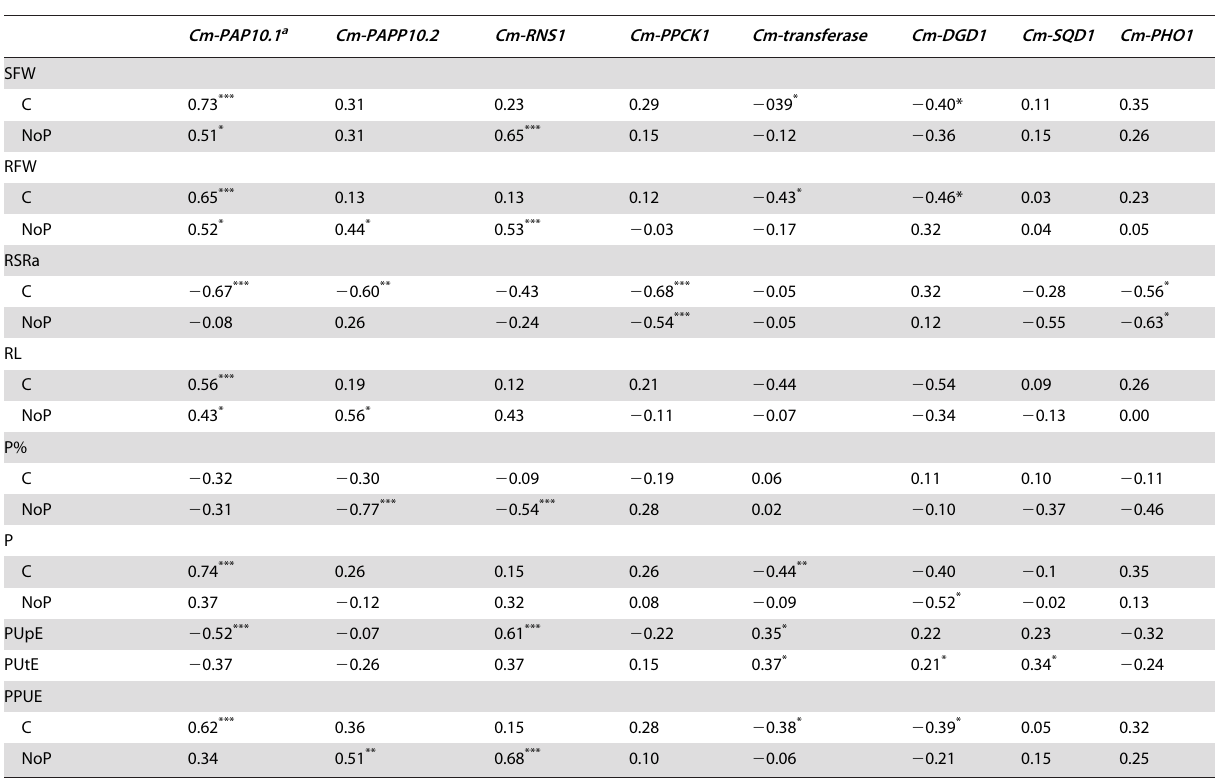
Table 2. Correlation among phenotypical traits and gene